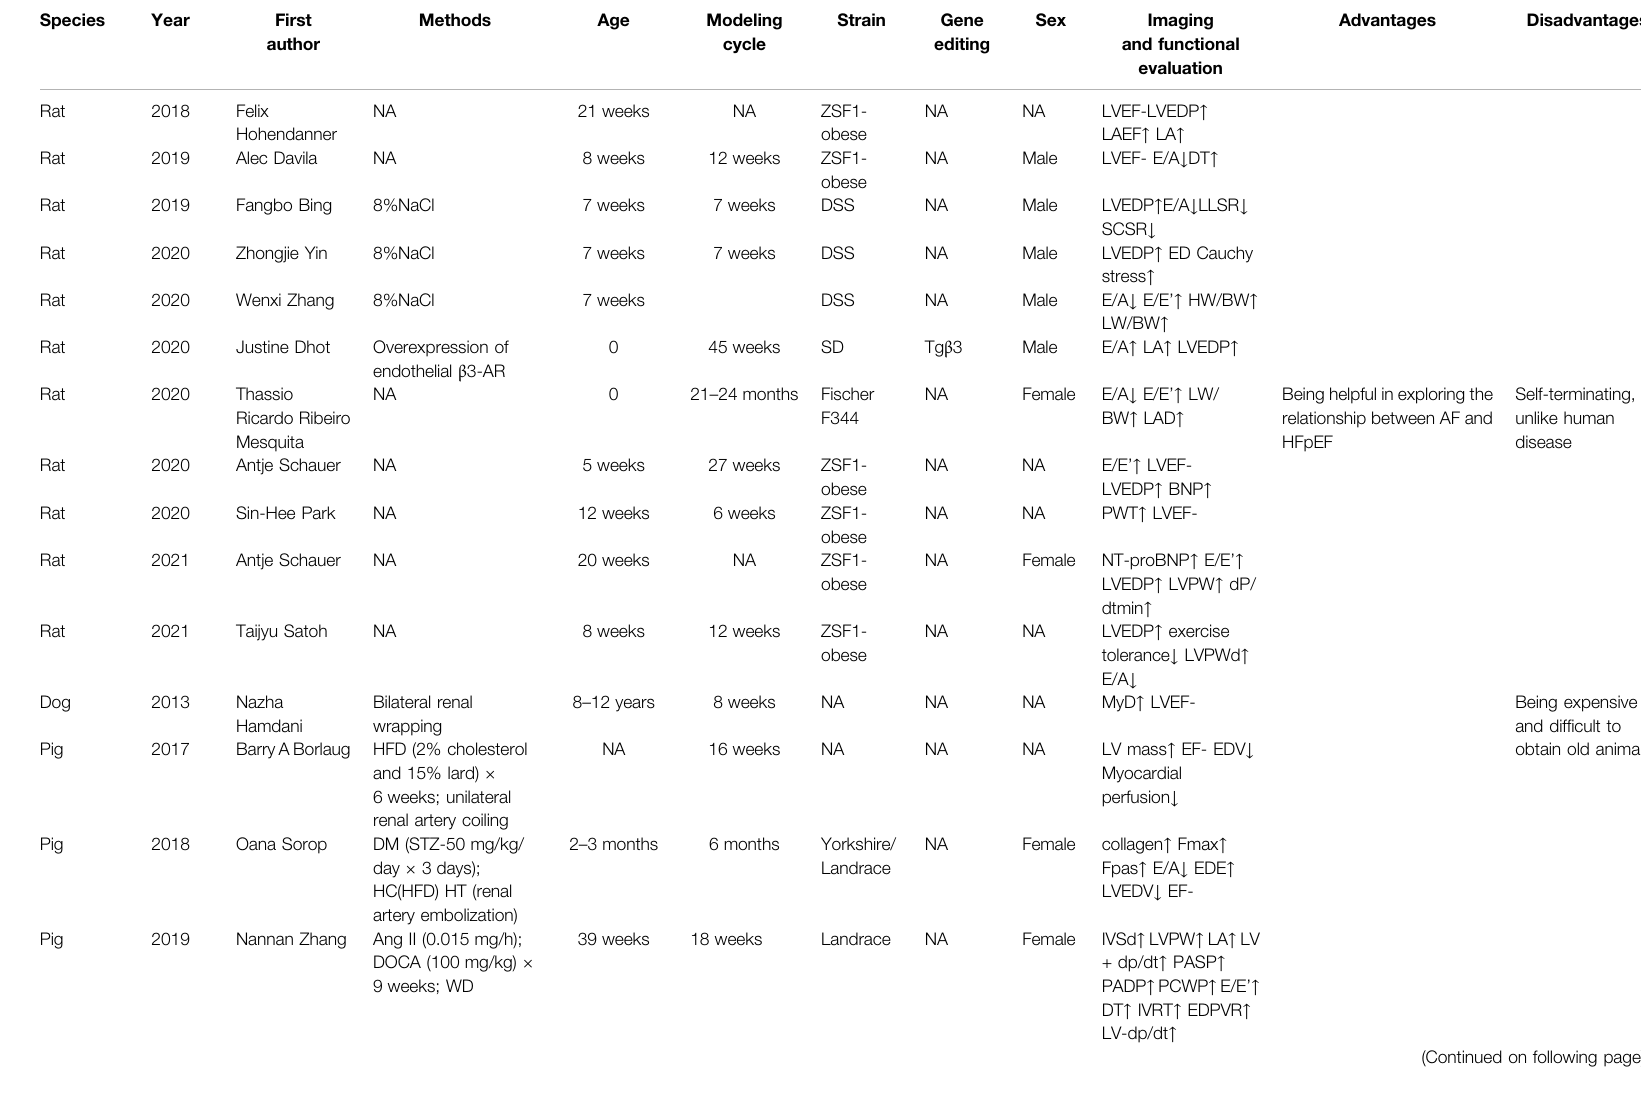
TABLE 1 | ( Continued ) Animal models for heart failure with preserved ejection fraction and metabolic